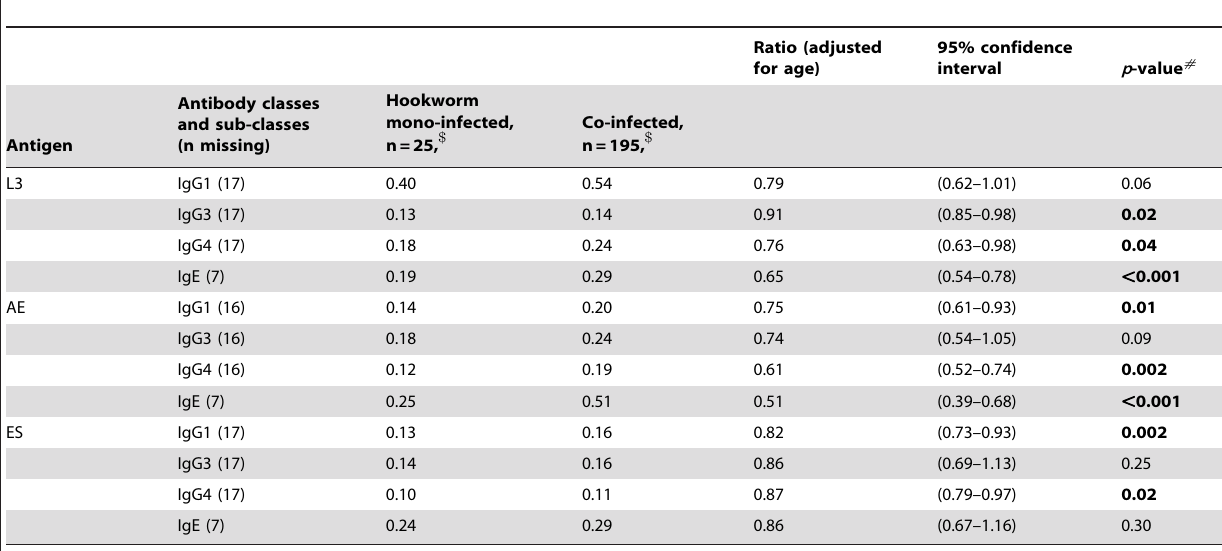
Table 3. Comparison of hookworm-specific antibody responses in sera from mono- and co-infected individuals.